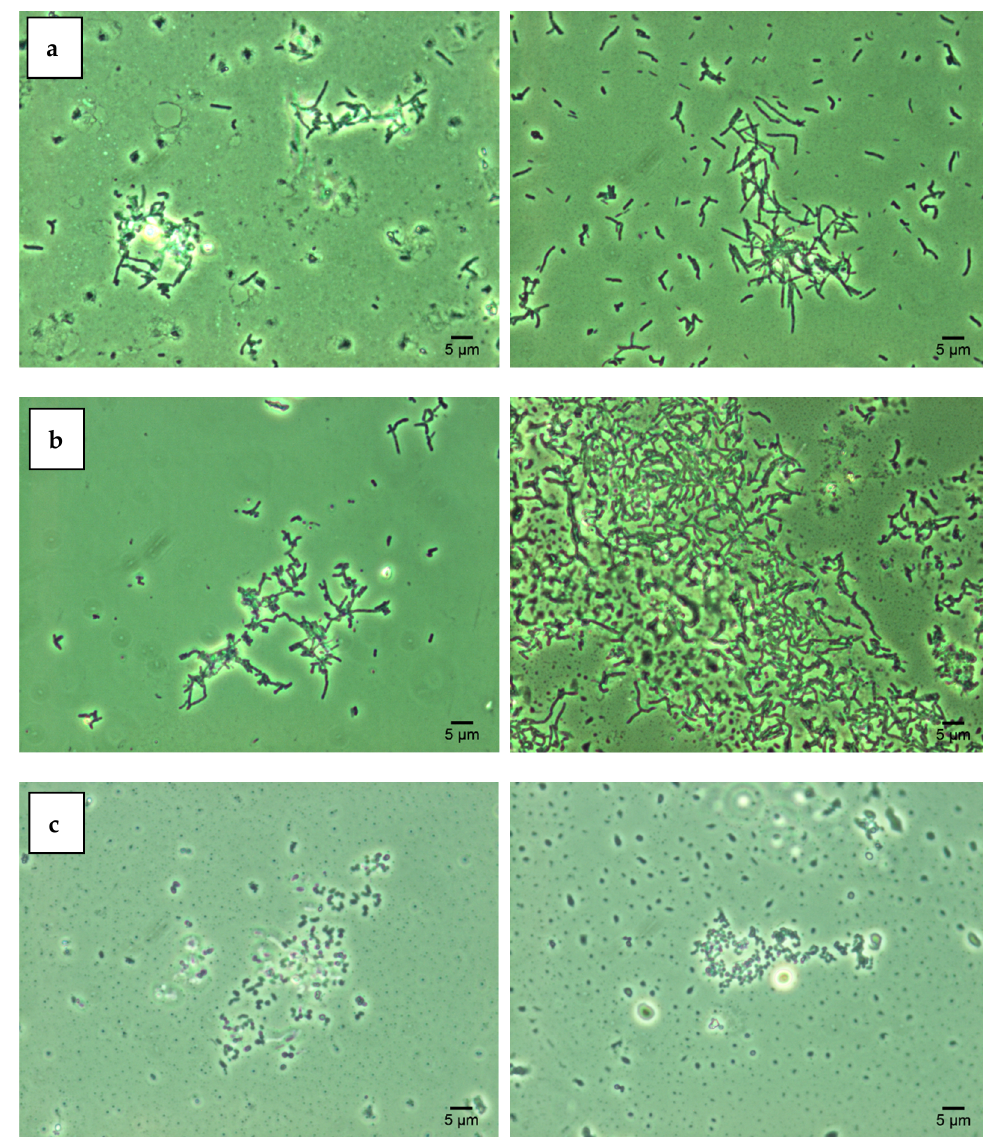
Figure 2. Autoaggregation of R. opacus IEGM 263 ( a ), R. rhodochrous IEGM 1363 ( b ), R. ruber IEGM 231 ( c ) cells in the presence of 0.2 M ammonium sulfate (SAT test): controls ( left ) and after 48-h incubation with 1.0 g/L Ni NPs ( right ). Phase-contrast microscopy × 1000.